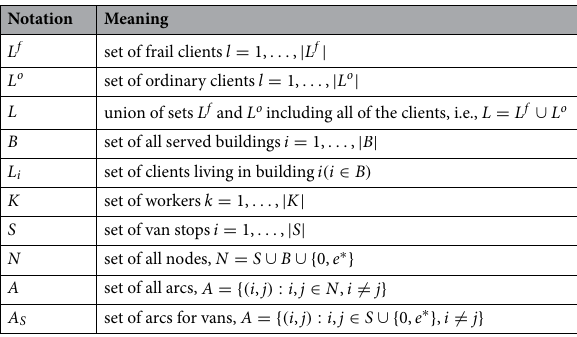
Table 1. Definitions for sets.